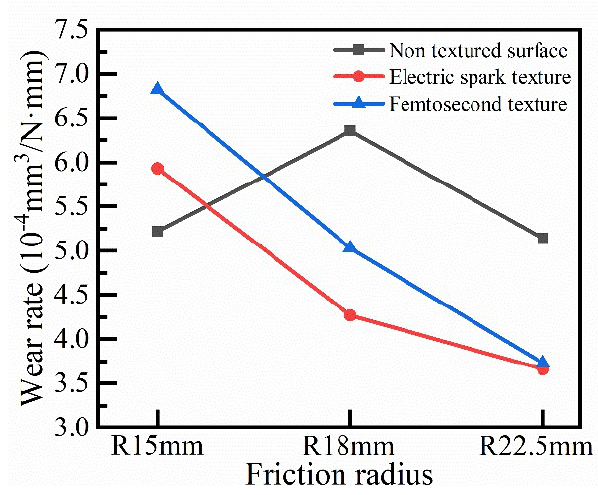
Figure 7. Wear rate of different